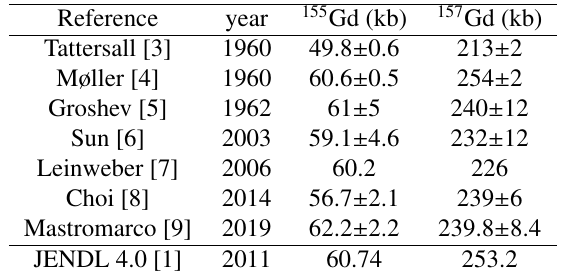
Table 1. Capture cross section data of 155 , 157 Gd in the